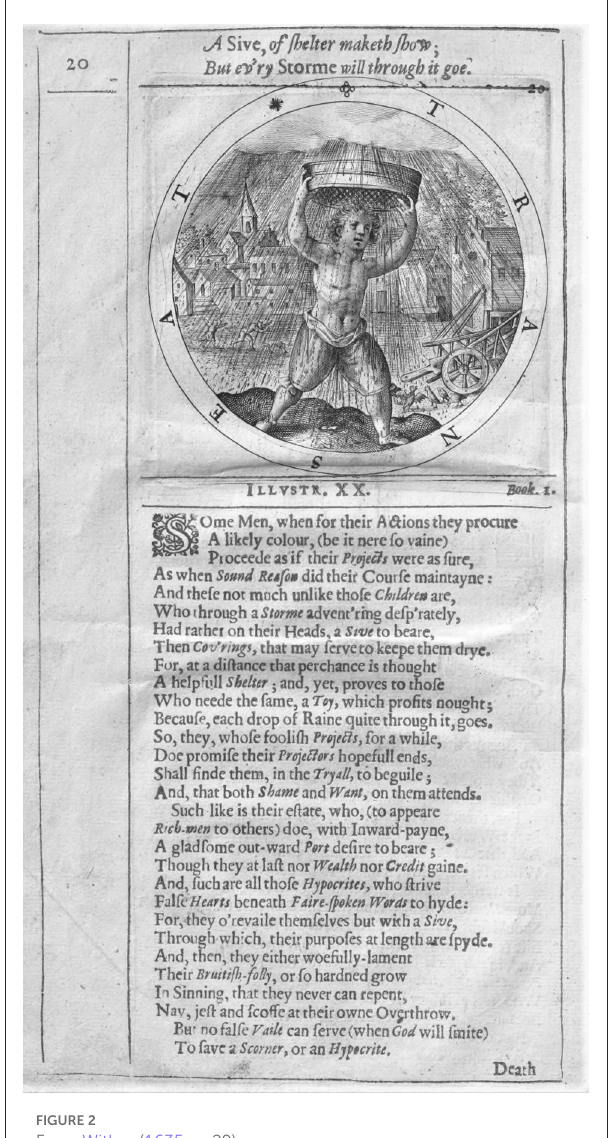
FIGURE2 From Wither (1635, p.